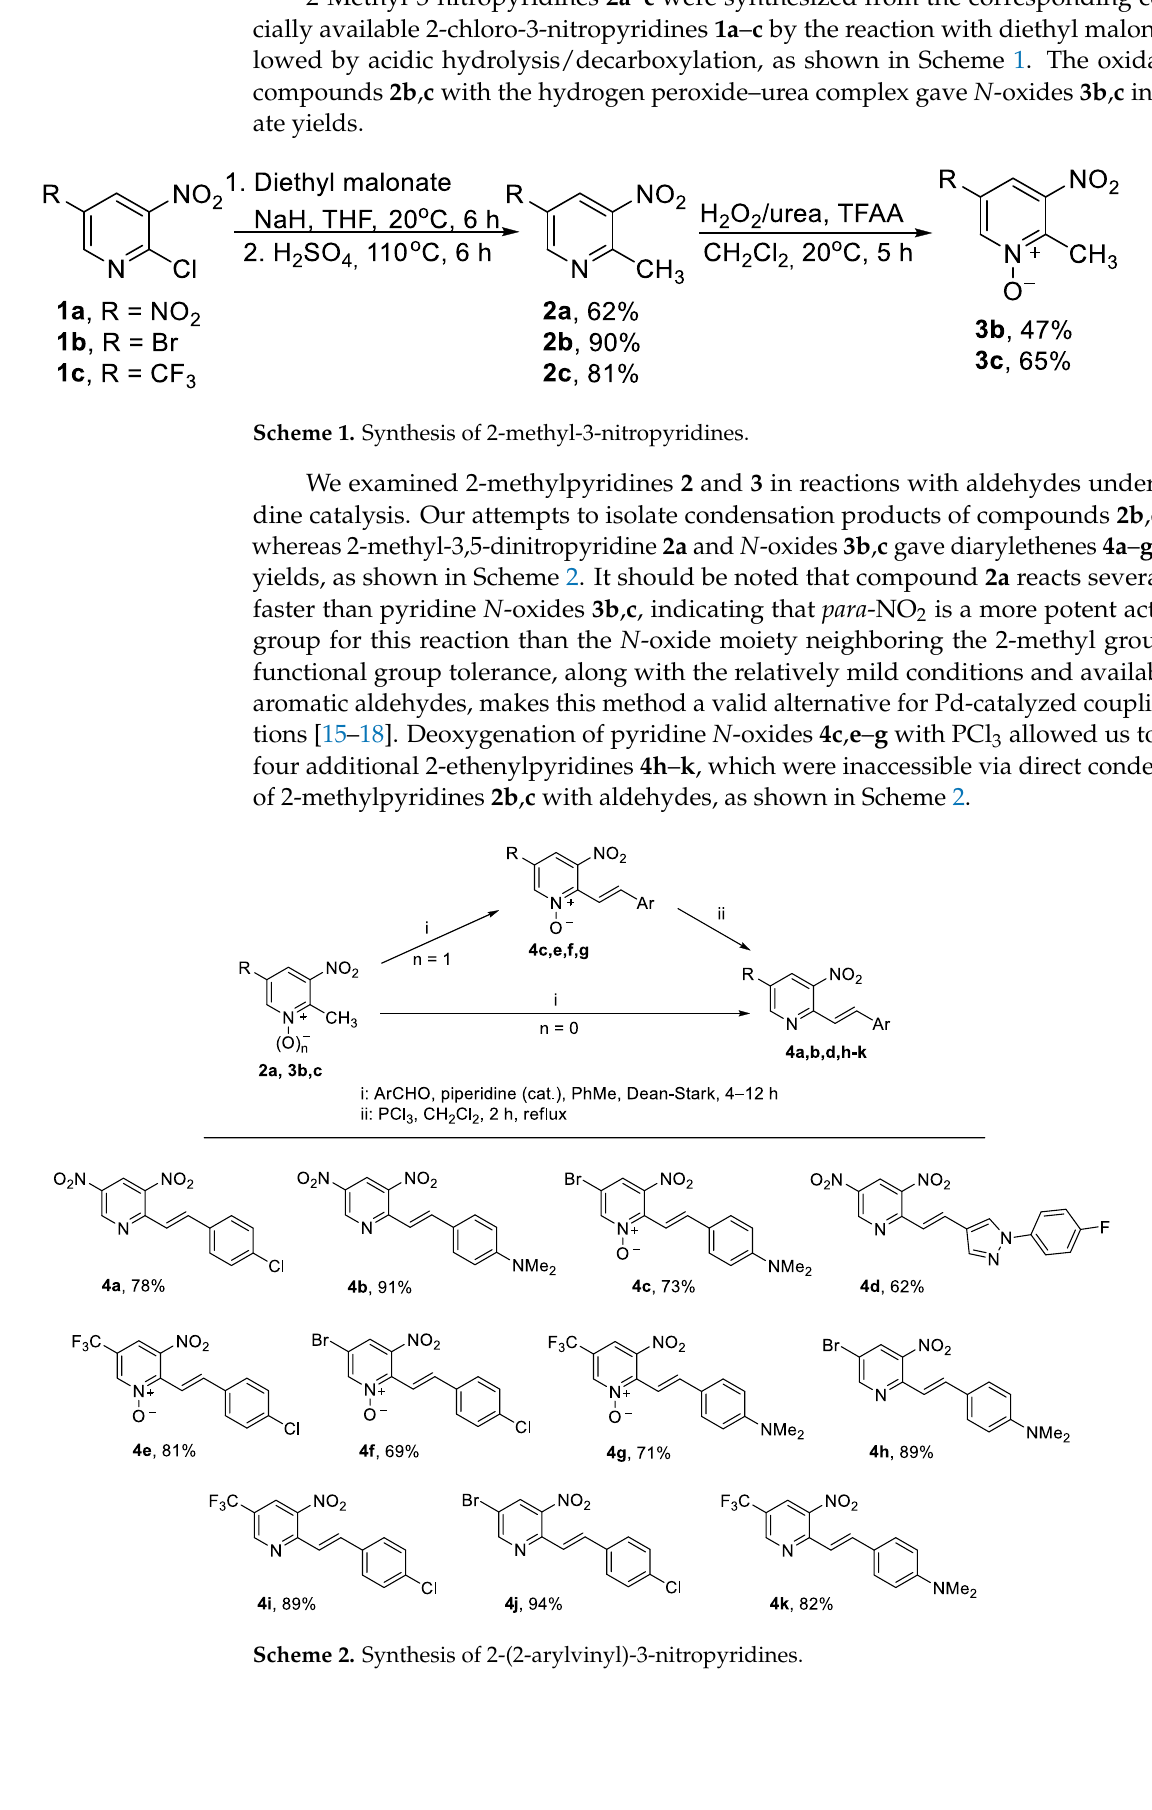
Figure 1. 2-Methyl- and 2-(2-arylvinyl)-3-nitropyridines synthesized and studied in this work.